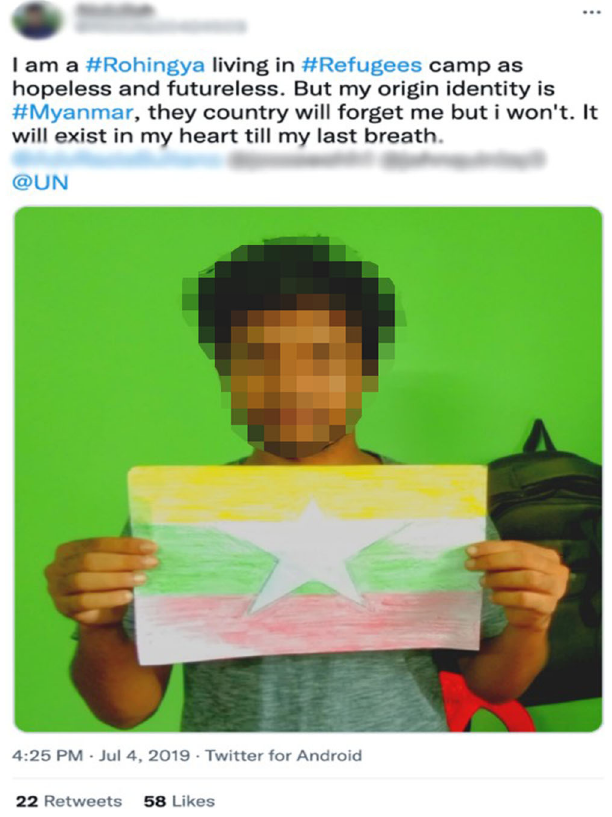
Fig. 3 A Rohingya refugee holding Myanmar ’ s fl ag to assert his Burmese identity. Rohingya youth asserting multiple belongings on Twitter.